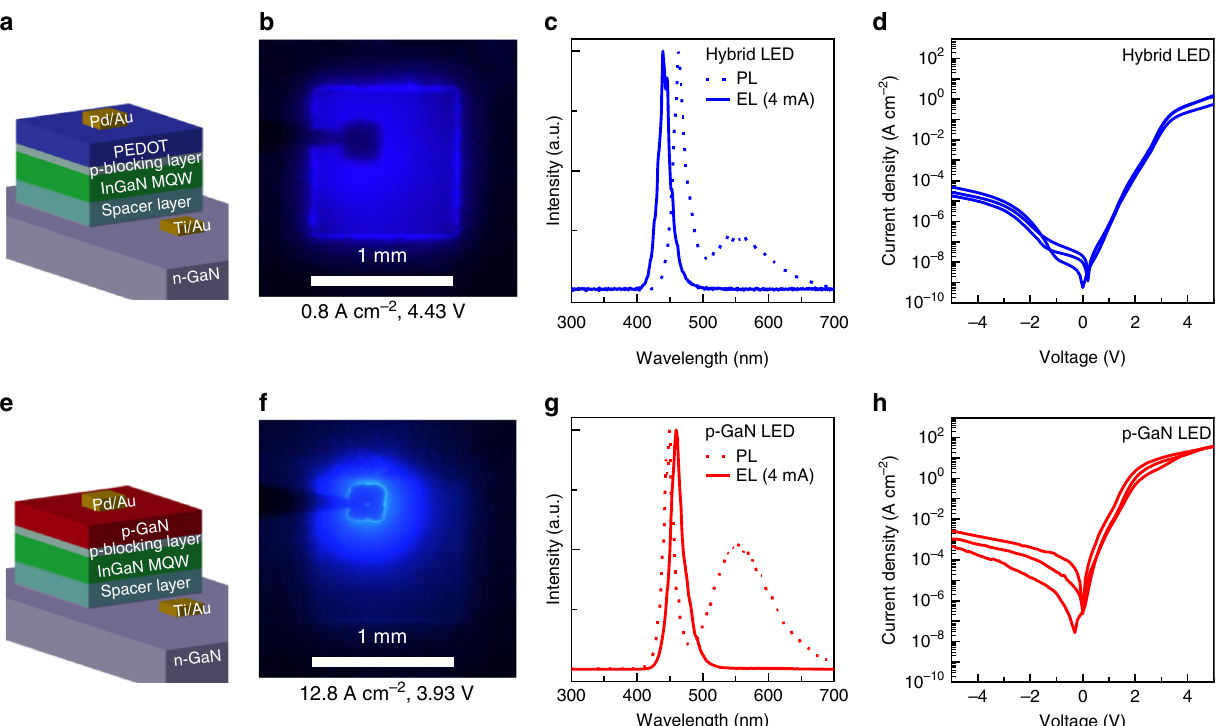
Fig. 4 Comparison of a hybrid and a conventional LED structure. a Sketch of the hybrid inorganic – organic LED where the p-GaN top layer was replaced with PEDOT. b Optical image of the hybrid LED at an applied voltage of 4.43 V reveals electroluminescence (EL) for the entire 1 × 1 mm 2 active area since PEDOT serves as a current spreading and hole-injection layer (scale bar: 1 mm). c Spectral analysis of photoluminescence (PL) excited at 325 nm and EL identi fi es the InGaN multi-quantum well as origin of the luminescence. d I – V measurements obtained for three identically constructed hybrid devices yield a series resistance of (170 ± 79) Ω . e Sketch of the conventional, purely inorganic p-GaN-based LED. f The optical image of the conventional planar LED at an applied voltage of 3.93 V features a smaller light-emitting area of the EL due to the limited lateral conductivity of the p-GaN layer (scale bar: 1 mm). g PL and EL peak wavelengths at ~450 nm con fi rm that the multi-quantum wells of the conventional and hybrid LEDs are similarly designed. h I – V analysis of the p-GaN-based device reveals a series resistance of (84 ± 7) Ω